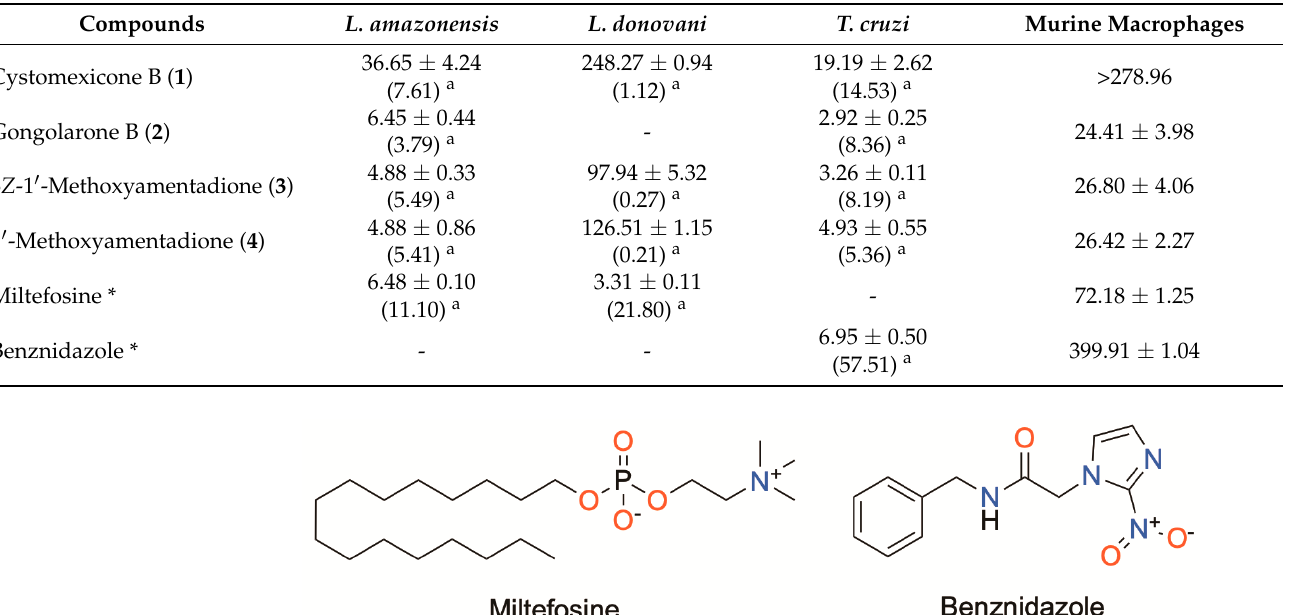
Table 1. Antikinetoplastid activity (IC 50 , μ M) and cytotoxicity (CC 50 , μ M) against eukaryotic cells of compounds 1 – 4 isolated from G. abies-marina . a Selectivity index (CC 50 /IC 50 ); * reference drugs; ± represents the standard deviation.